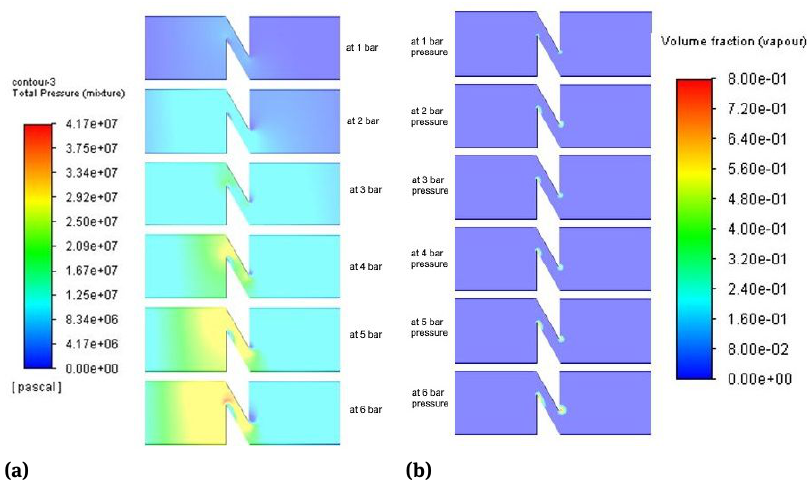
Figure 8: (a) – Pressure distribution (pressure drop at vena contracta) shown at different inlet pressures. (b) – Vapor fraction (cavitation) was represented at different inlet pressures ranging 1–6 bars